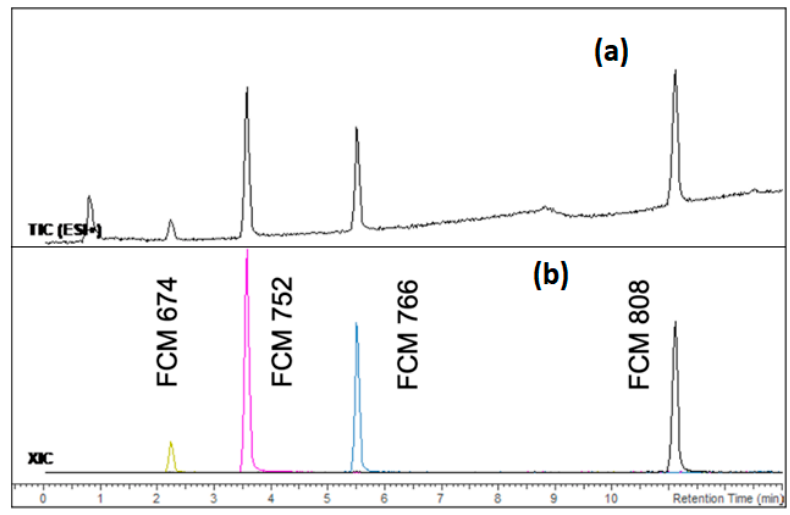
Figure 2. UHPLC-QTOF MS TIC ( a ) and XIC ( b ) of the studied target sorbitol-based nucleating agents (100 μ g L − 1 ).